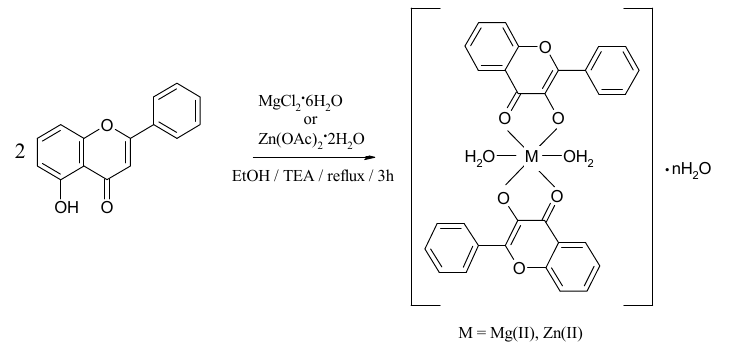
Scheme 1. The reaction scheme for the synthesis of the complexes.